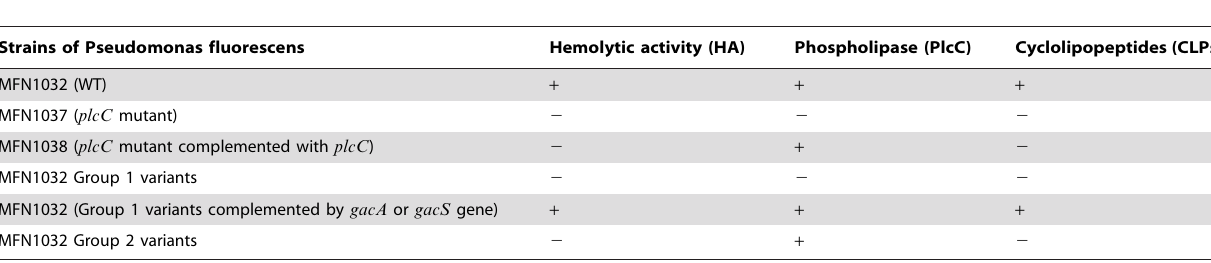
Table 1. Summary of experimental results concerning the production of hemolytic activity, phospholipase C and cyclolipopeptides in different genetic